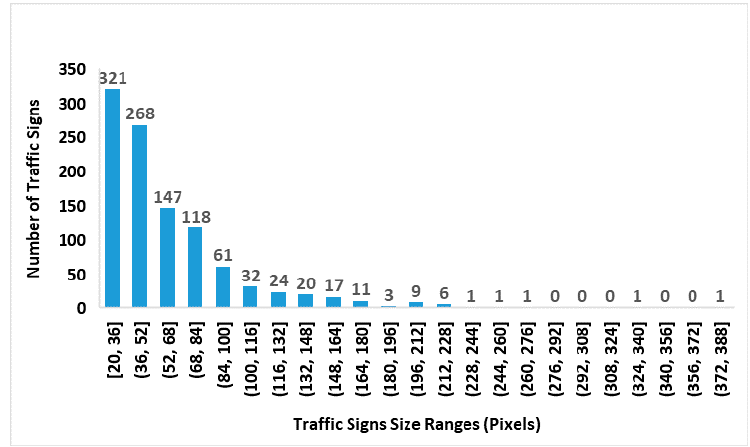
Figure 12. A histogram of the traffic sign size distribution in the Chinese traffic sign dataset (CTSD).